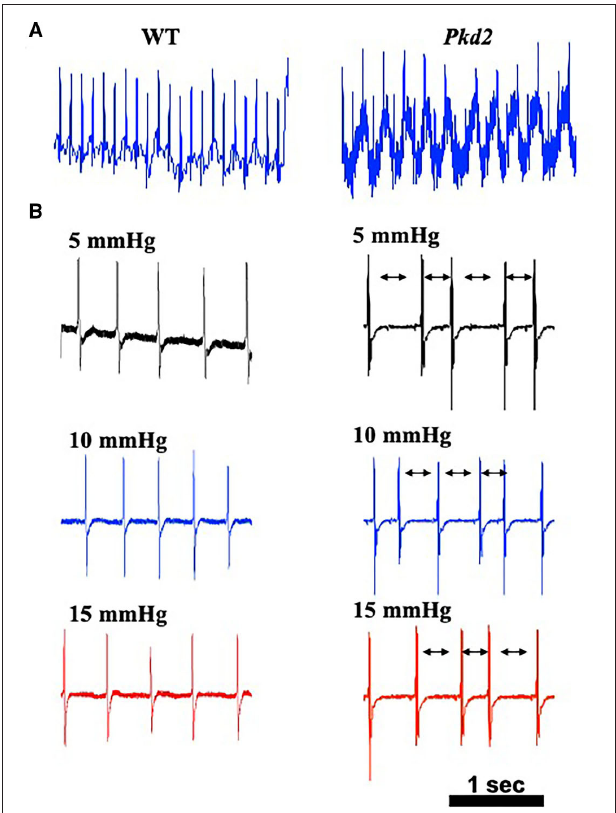
FIGURE 4 | The hearts from Pkd2 -KO mice with no autonomic input have irregular beats. (A) Representatives of in vivo electrocardiogram (ECG) are shown with averaged frequency of 540–600 beats/min in wild-type (WT) and Pkd2 -KO ( Pkd2 ) mice. (B) Representatives of ex vivo ECG with no autonomic input are shown with different preloads of 5, 10, and 15 mmHg. The Pkd2 -KO heart ECG shows irregular heartbeat with normal QRS shape. All ECG from Pkd2 -KO showed irregular R-R intervals (arrows). N = 3–4 mice for each WT and Pkd2 -KO age-matched 6 months old.